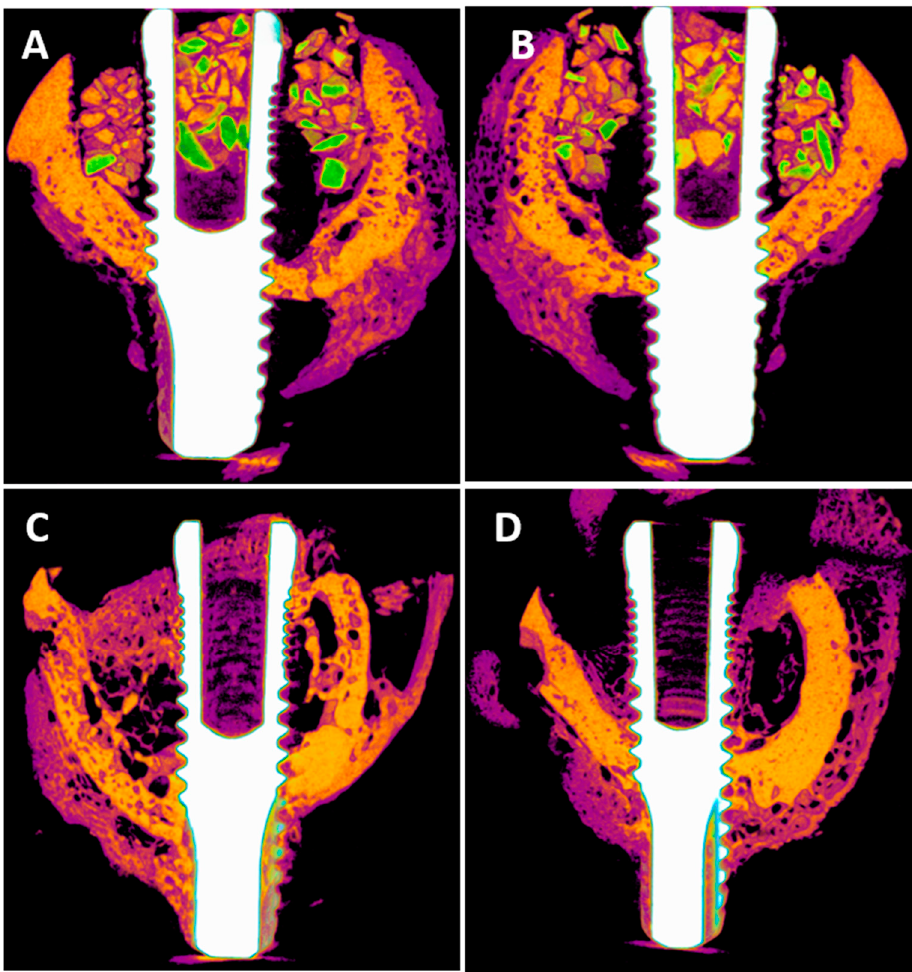
Figure 2. Micro computed tomography (CT) images of regenerated new bone in peri-implant defects at 8 weeks. ( A ) Defect filled with tooth biomaterial and platelet-rich fibrin (PRF). ( B ) Tooth biomaterial was grafted into defect. ( C ) The PRF was grafted into the defect. ( D ) Unfilled defects around the implant neck served as controls.